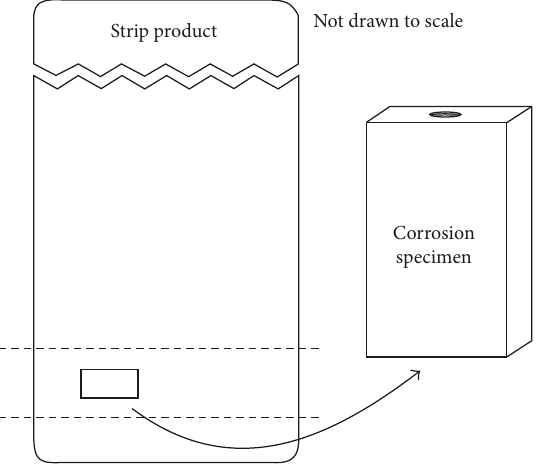
Figure 2: Preparation of corrosion specimens from the hot rolled